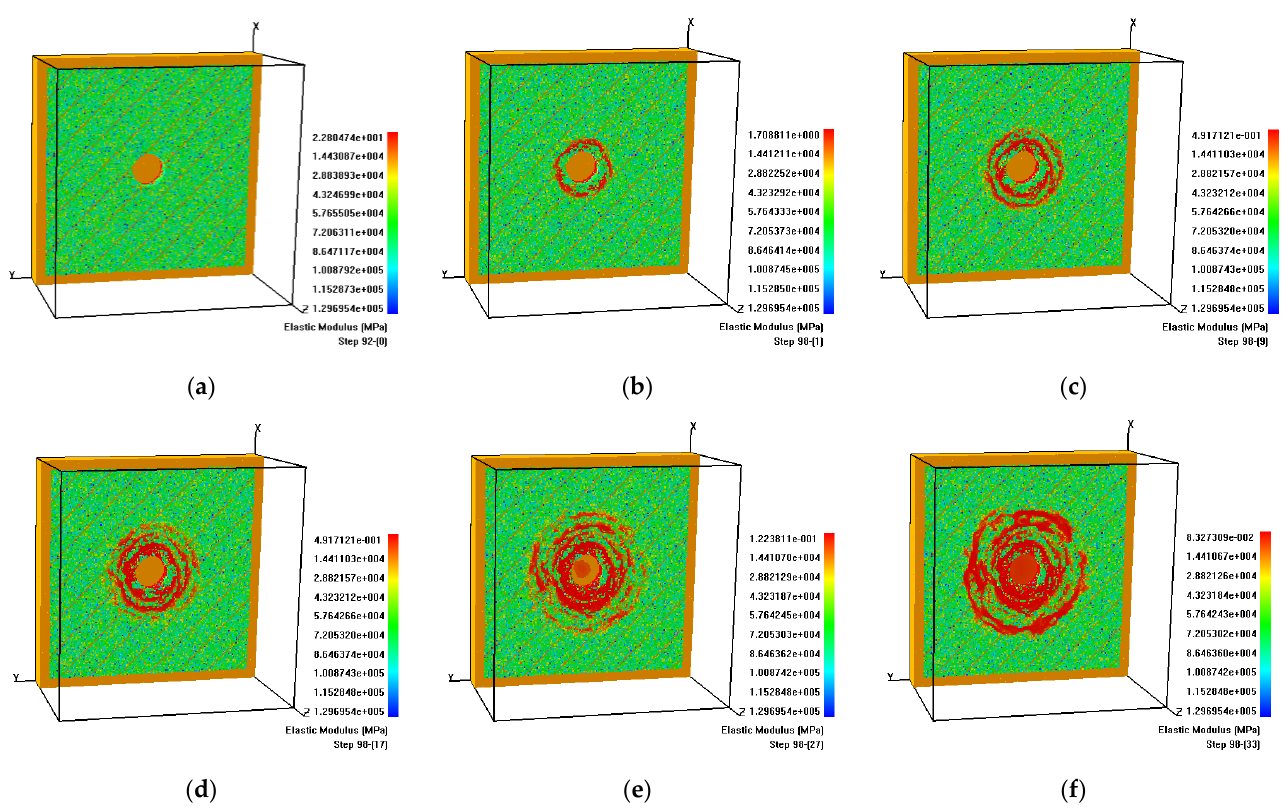
Figure 10. Distribution of elastic modulus during zonal disintegration process of surrounding rock with Model B45: ( a ) Step 92-0; ( b ) Step 98-1; ( c ) Step 98-9; ( d ) Step 98-17; ( e ) Step 98-27; ( f ) Step 98-33.